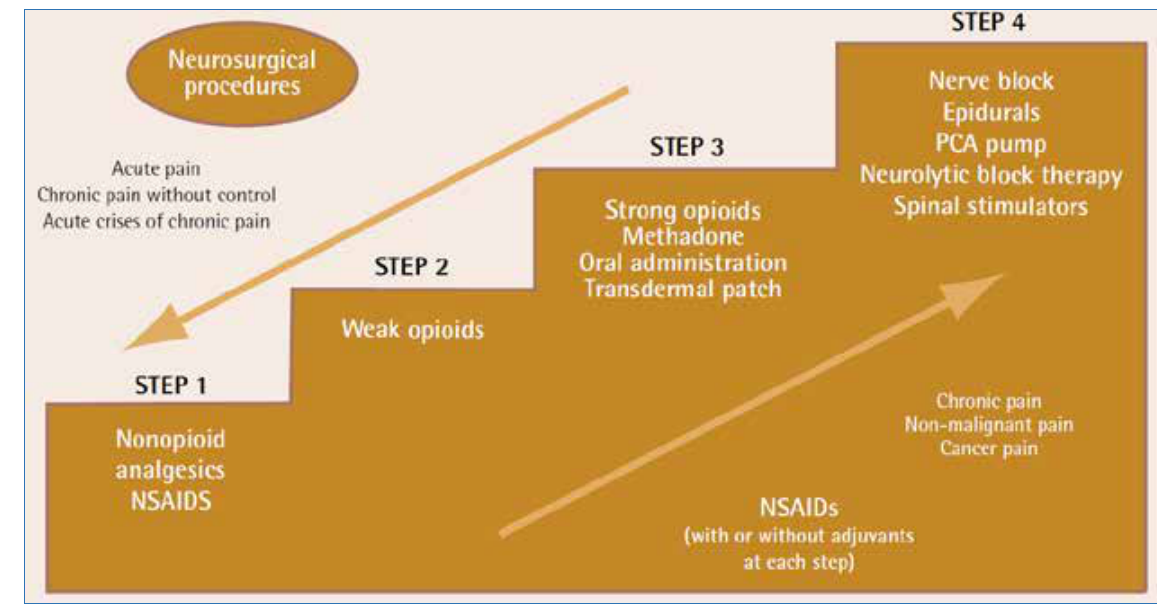
Figure 1: Modified analgesic ladder 18 NSAIDs – Nonsteroidal anti-inflammatory drugs. PCA – Patient-controlled analgesia